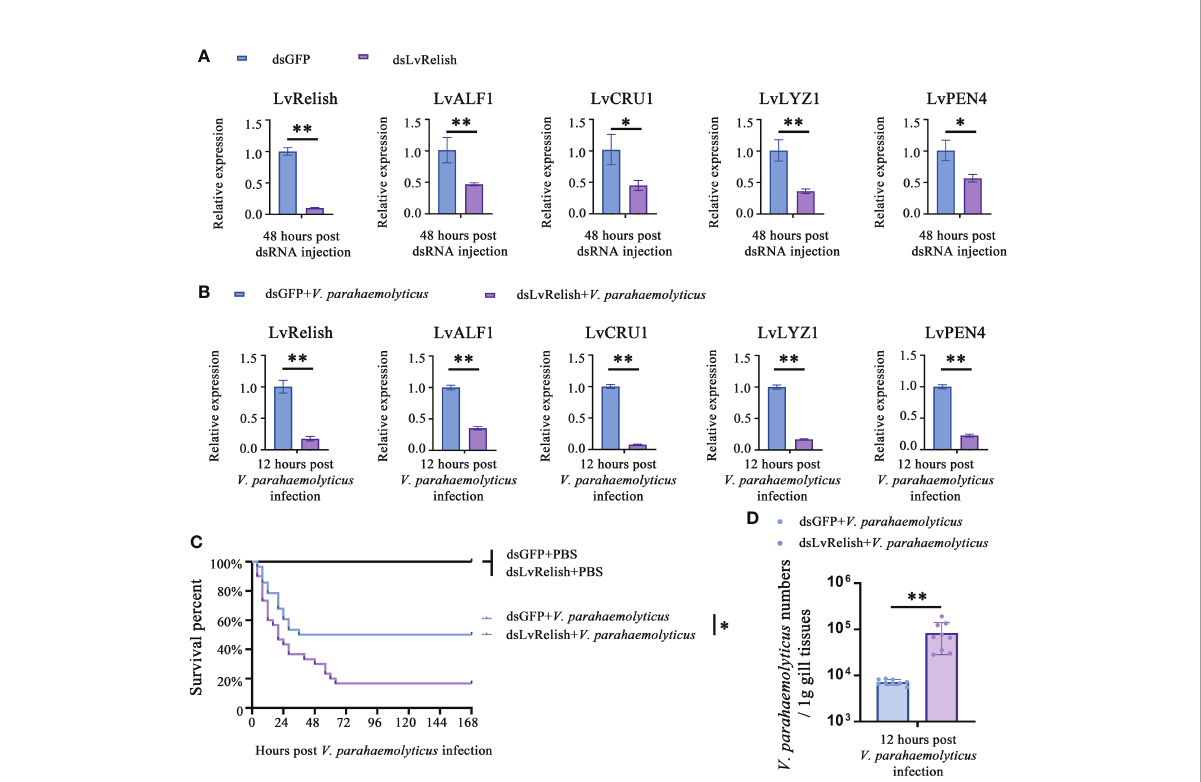
FIGURE 1 LvRelish defended against V. parahaemolyticus infection via inducing AMPs. (A) Relative expression of LvRelish and AMPs in LvRelish silenced shrimp at 48 hours post dsRNA injection. (B) Relative expression of LvRelish and AMPs in LvRelish silenced shrimp at 12 hours post V. parahaemolyticus infection. (C) Percent survival of LvRelish silenced shrimp after V. parahaemolyticus infection. The experiments were performed three times with identical results. Differences between groups were analyzed with Log-rank test using the software of GraphPad Prism 5.0 (* p < 0.05). (D) V. parahaemolyticus numbers in gill tissues of LvRelish silenced shrimp at 12 hours post V. parahaemolyticus infection. One dot represents one sample and the column represents the median of the results. The data (A, B, D) was analyzed statistically by student ’ s T test (* p < 0.05, ** p <